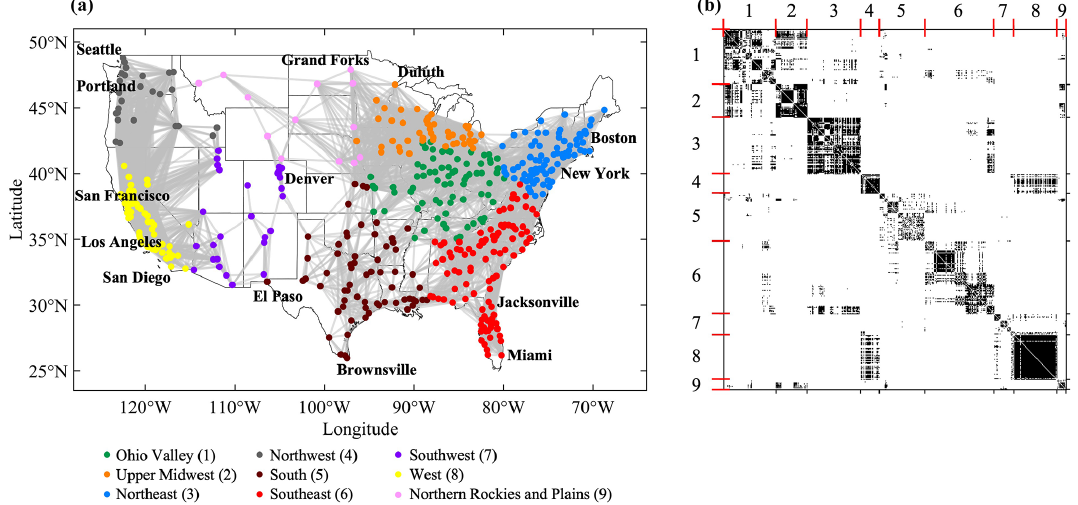
Figure 4. The precipitation network of CONUS cities: (a) the geographic map of connectivity and (b) the adjacency matrix, with A ij = 1 in black (connected), A ij = 0 in white, and the short red lines marking the divisions of the nine geographic regions in accordance with panel (a) .